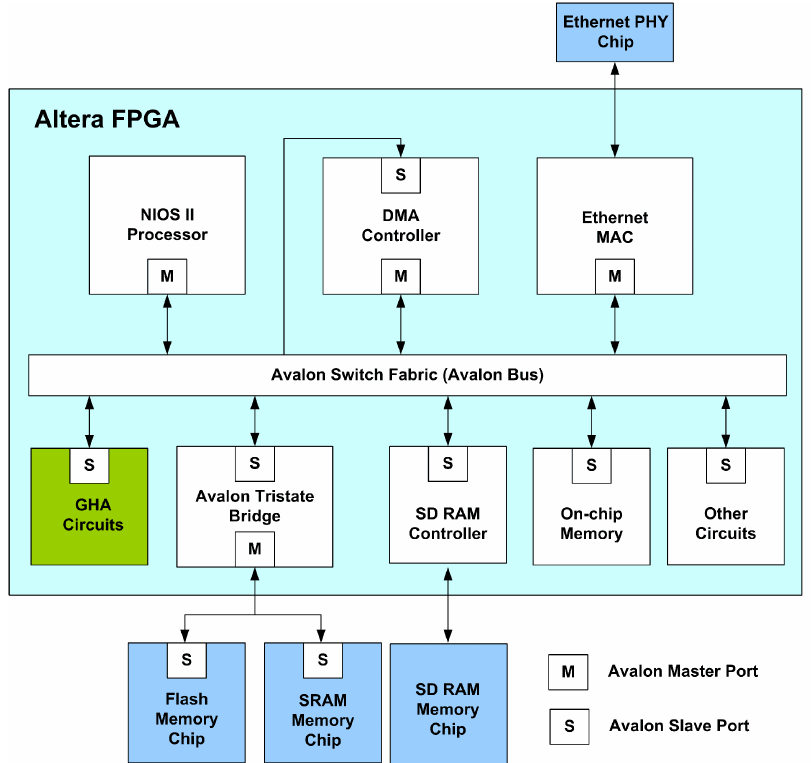
Figure 15. The SOPC system for implementing GHA.